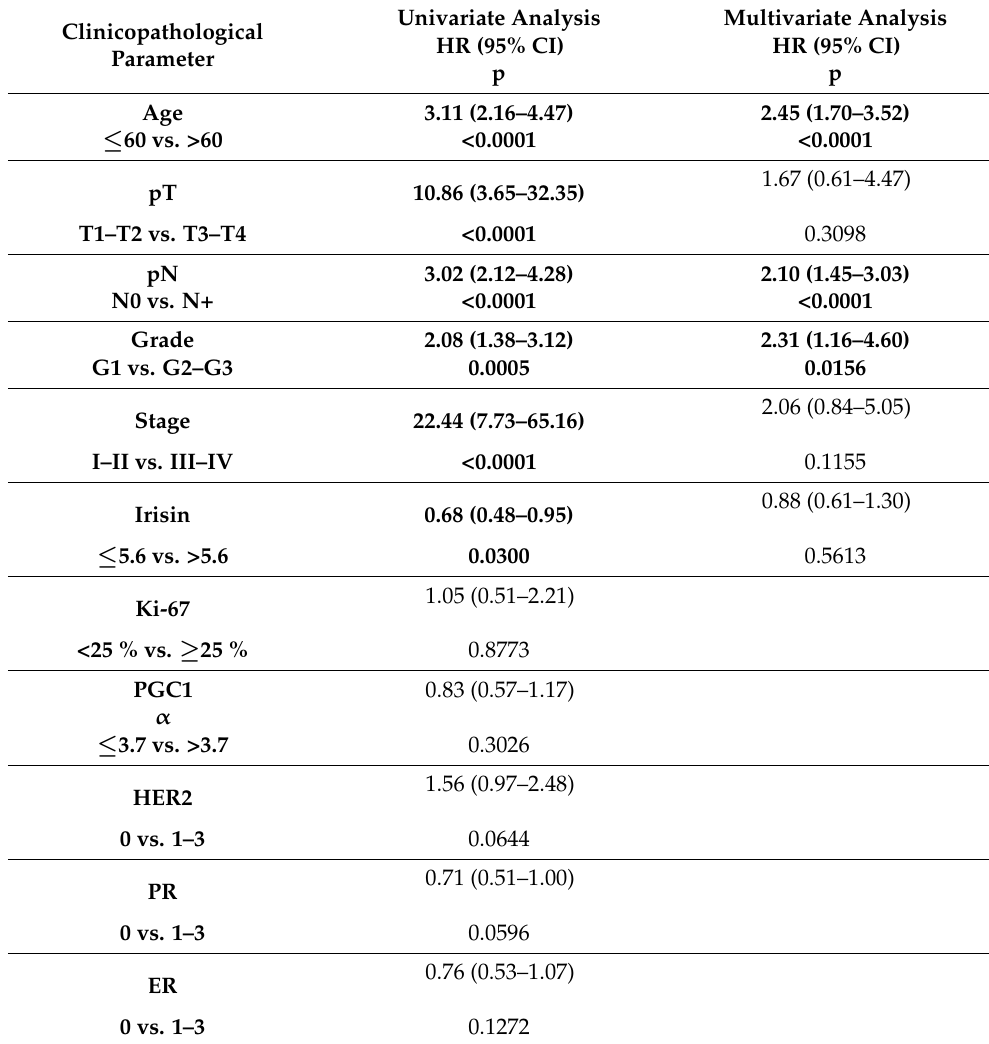
Table 3. Univariate and multivariate Cox proportional hazards analyses in 541 patients with